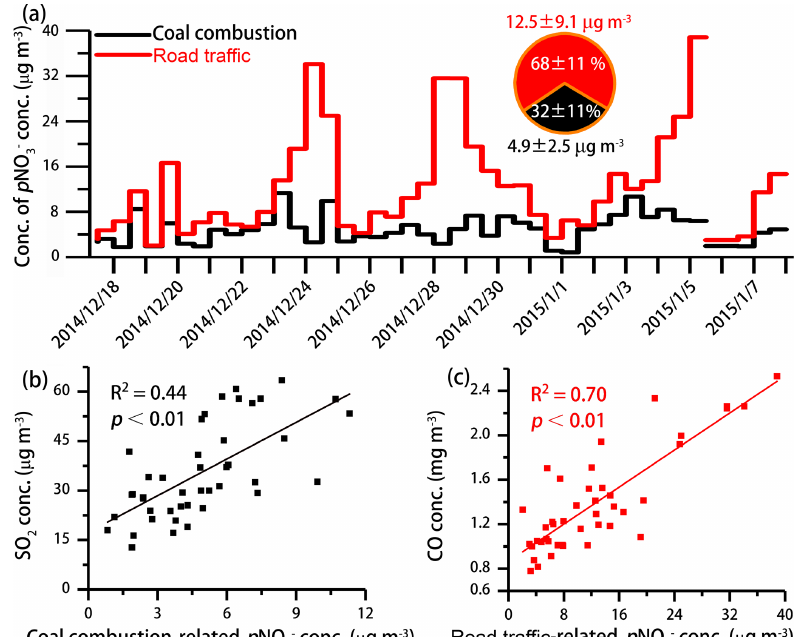
Figure 5. (a) Time-series variation of coal combustion and road traffic contribution to the mass concentrations of ambient p NO − jing, as estimated through MixSIR; (b) correlation analysis between the mass concentrations of coal-combustion-related p NO − (c) correlation analysis between the mass concentrations of road-traffic-related p NO −